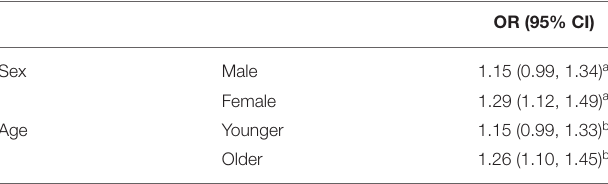
TABLE 2 | Sex-stratified and age-stratified association between levels of food insecurity and bullying